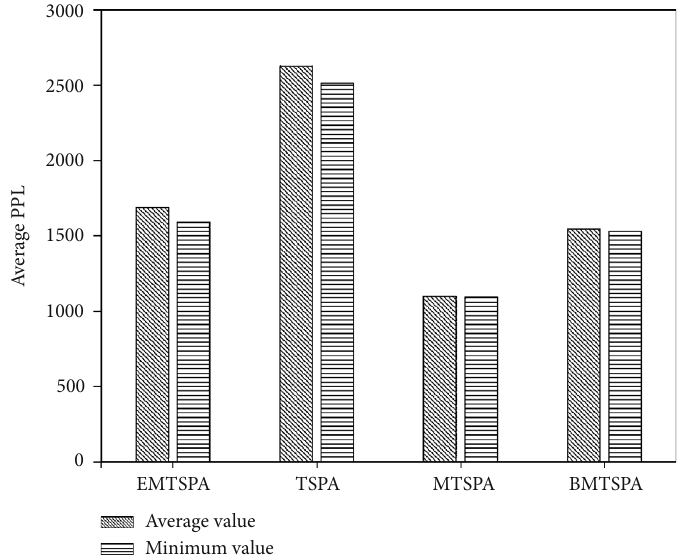
Figure 9: Comparison of average PPL.